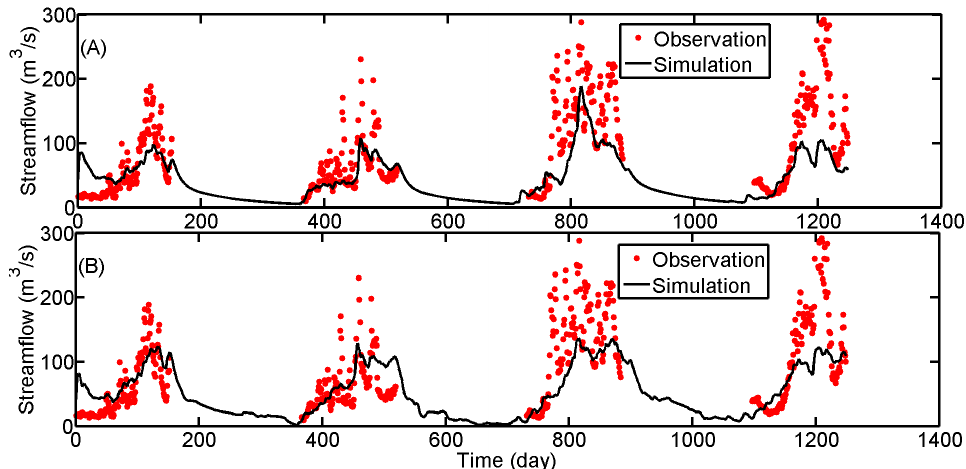
Figure 6. Daily observed streamflow at the outlet of the Tuotuo River Basins for both: ( A ) Open Loop HBV simulated results obtained without data assimilation and ( B ) case C10 data assimilation results between 1 May 2007 and 30 September 2010.